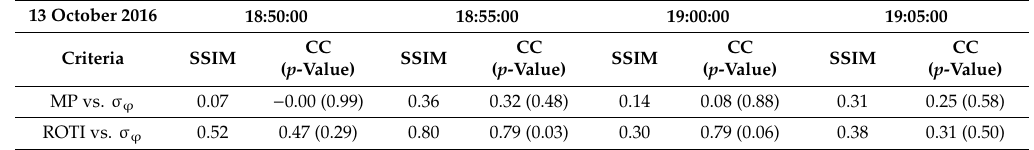
Table 22. SSIM and CC between the maps shown in Figure 18.